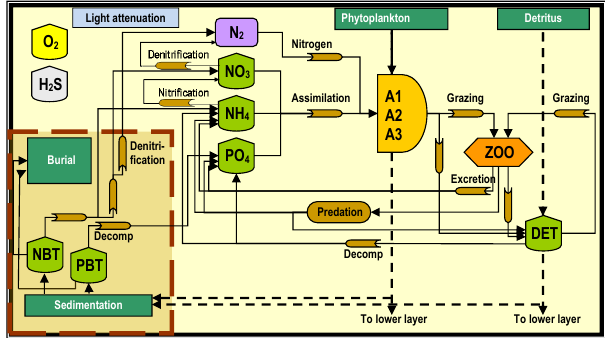
Figure 3. Schematic figure of the Swedish COastal and BIogeo- chemical model, SCOBI. Oxygen and hydrogen sulfide are simpli- fied for